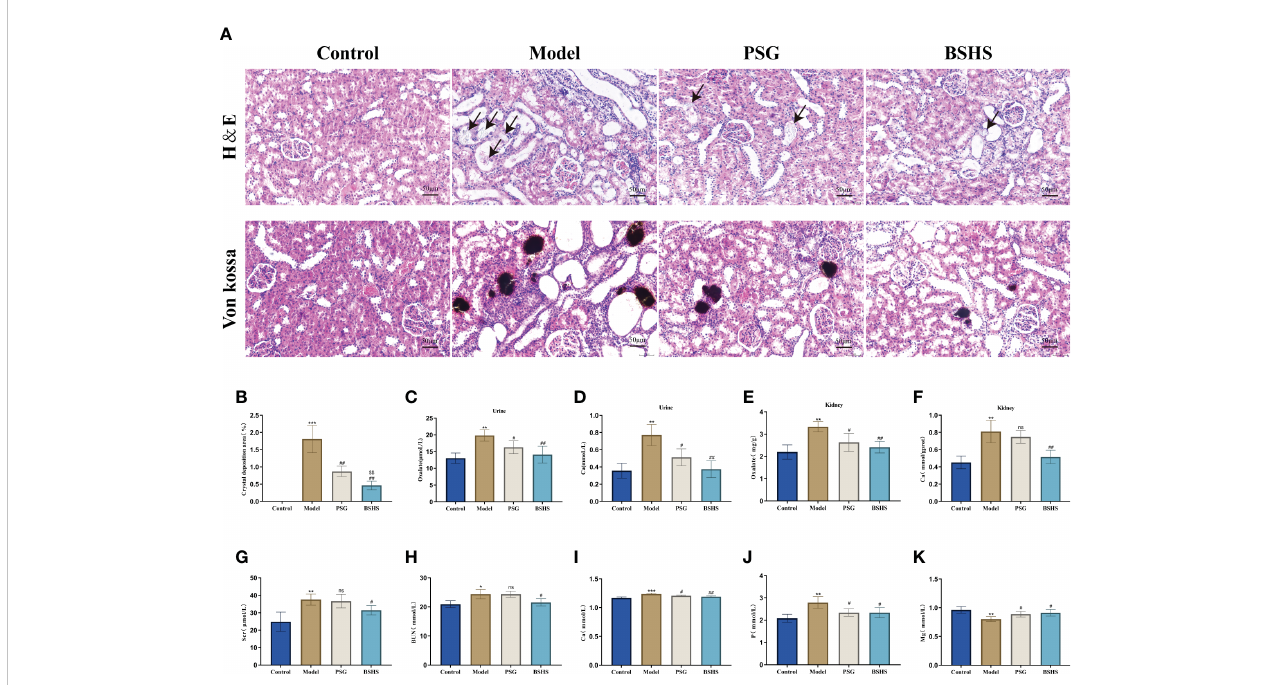
FIGURE 3 The therapeutic effect of BSHS on KS. (A) The H&E and Von Kossa staining of kidney sections from each group revealed tissue injury and CaOx crystal deposition. (B) The Image J (USA) software calculated the percentage of area positively stained for crystal deposition in each kidney section based on 20 random views at 200× magni fi cation. (C) Oxalate content in the rat urine. (D) Ca content in the rat urine. (E) Oxalate content in the rat kidneys. (F) Ca content in the rat kidneys. (G) Cr content in the rat serum. (H) Blood urea nitrogen (BUN) content in the rat serum. (I) Ca content in the rat serum. (J) P content in the rat serum. (K) Mg content in the rat serum. All values were expressed as mean ± SD. *p <0.05 vs . the normal control group, **p < 0.01 vs . the normal control group, ***p < 0.001 vs . the normal control group, # p < 0.05 vs . the model group, ## p < 0.01 vs . the model group, $$ p < 0.01 vs . the PSG group, ns for p >0.05 vs . the model